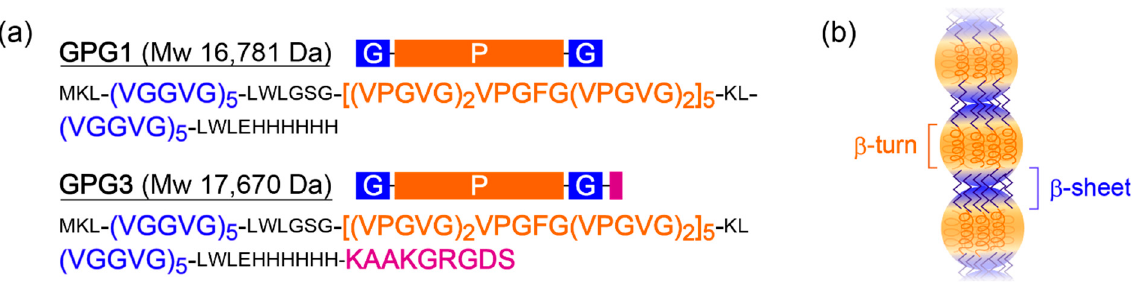
Figure 1. ( a ) Amino acid sequences of GPG1 and GPG3. ( b ) Plausible structural model for nanofibers of GPGs. GPG1 and GPG3 were each dissolved at 0.5 wt% in 10 w/v% sucrose aqueous solution